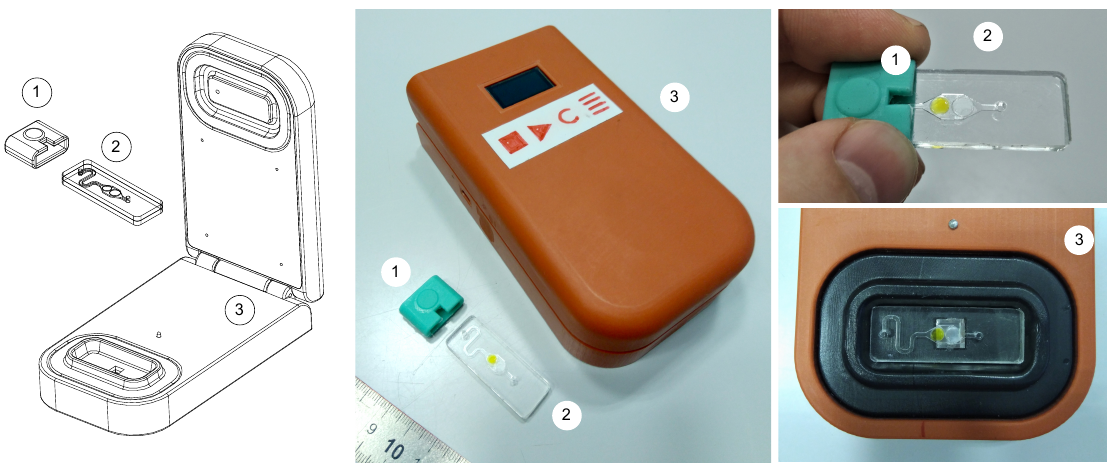
Figure 1. The biosensor consists of a SiPM-based handheld luminometer (3), a disposable microfluidic chip (2) and a sampler adapter for chips (1). The portable luminometer has the capability of autonomous operation, for this purpose it is equipped with a battery, a display and control buttons. The disposable microfluidic chips contain enzymes and substrates of the coupled enzyme bioluminescent system NAD(P)H:FMN-oxidoreductase+luciferase co-immobilized into starch